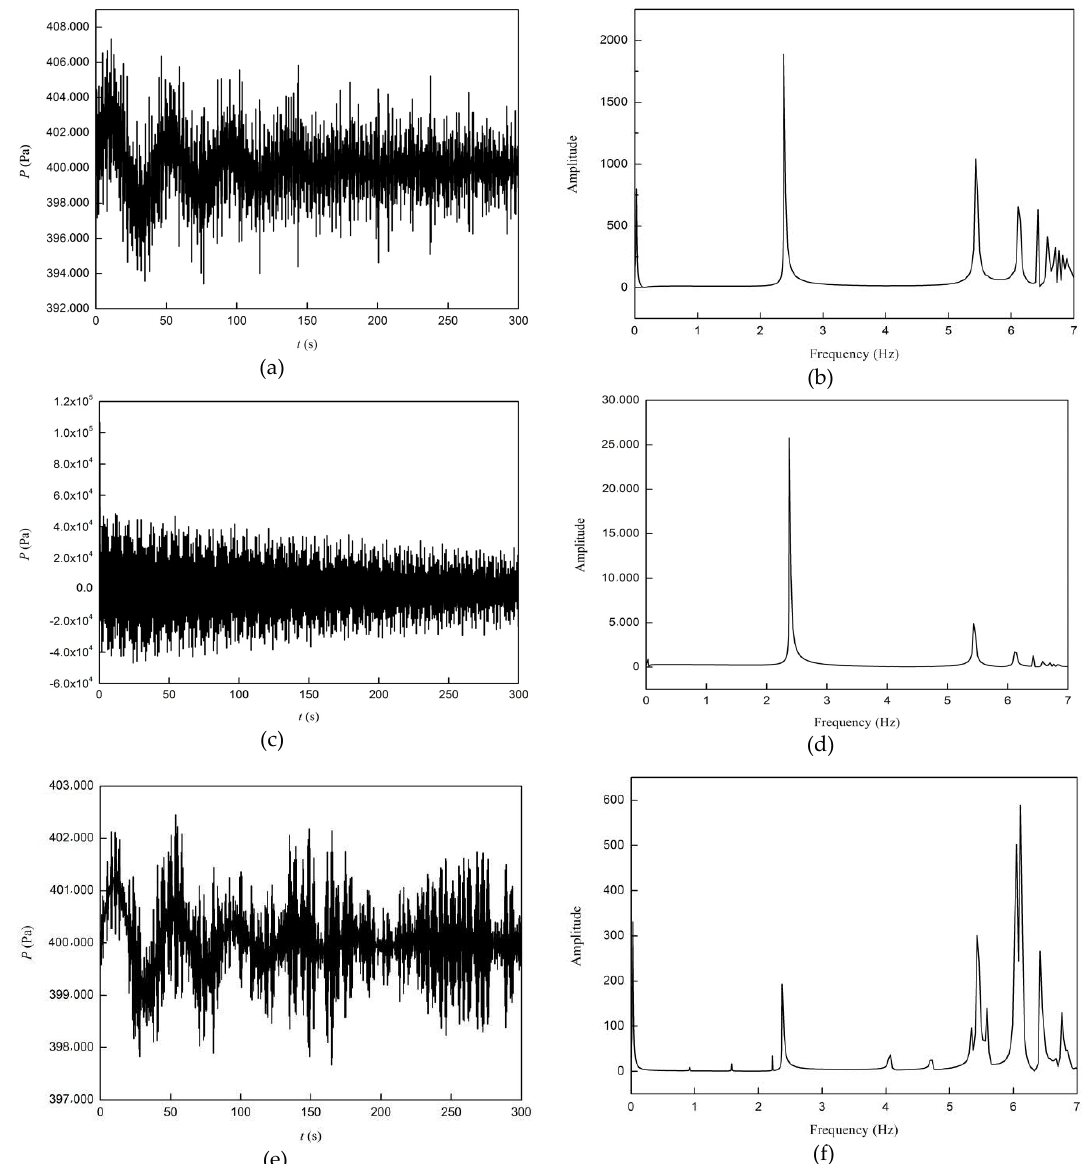
Figure 11. Time history and frequency responses of dynamic pressure. ( a ), ( c ) and ( e ) are time histories of dynamic pressure near surge chamber, at the outlet and at the elbow. ( b ), ( d ) and ( f ) are frequency responses of dynamic pressure near surge chamber, at the outlet and at the elbow. When ν =0.3 , Poisson coupling and junction coupling both exit in the system. When ν =0 , there is